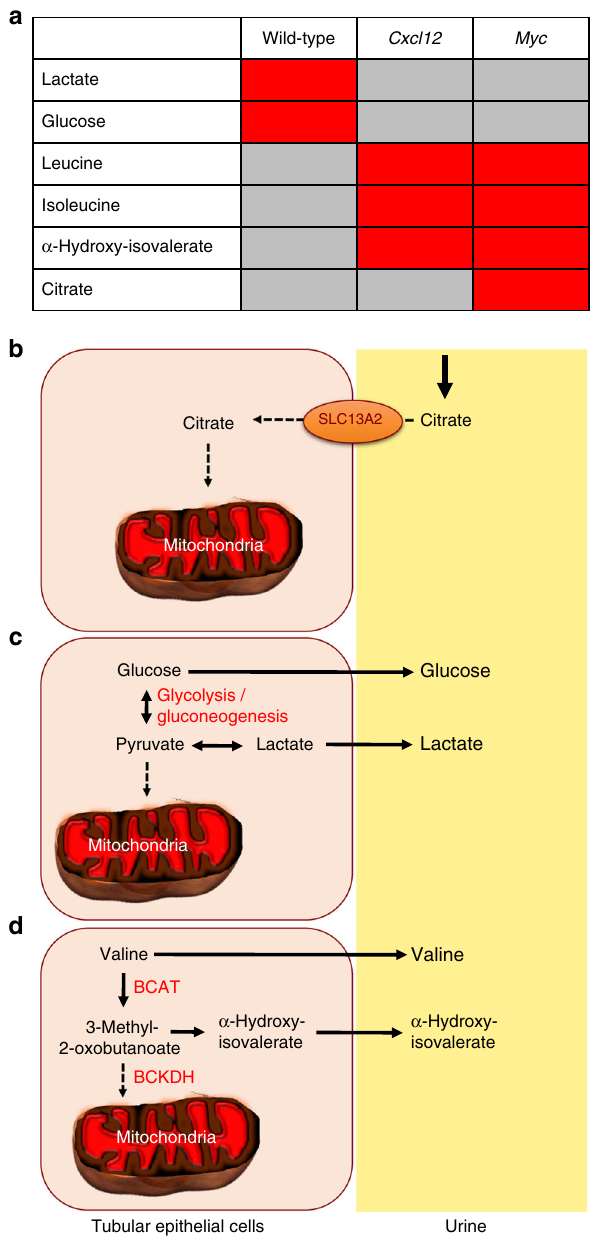
Fig. 8 Key metabolite changes after Cxcl12 or Myc deletion. a While lactate and glucose were elevated after ischemia/reperfusion (I/R) injury in the urine of wild-type animals (red box), leucine/isoleucine, α -hydroxy- isovalerate and citrate were elevated in the urine of knockout (KO)